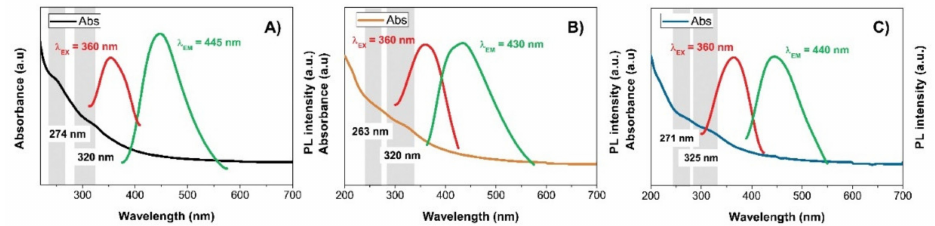
Figure 3. UV-vis absorption spectrum with maximum fluorescence excitation and emission spectrum of ( A ) Pure CQD, ( B ) CQD@Gly, and ( C )